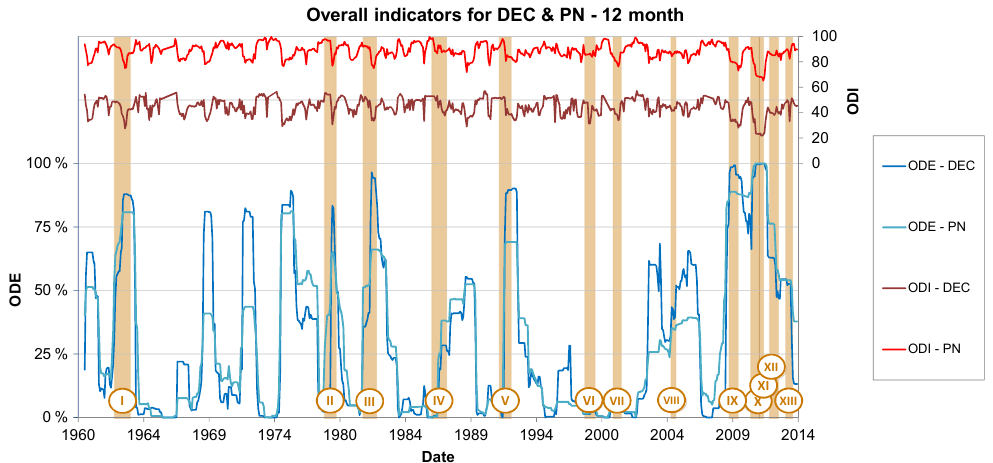
Figure A8. ODE and ODI values using the 12-month timescales of DEC and PN indices, compared with the 13 detected historical droughts (in